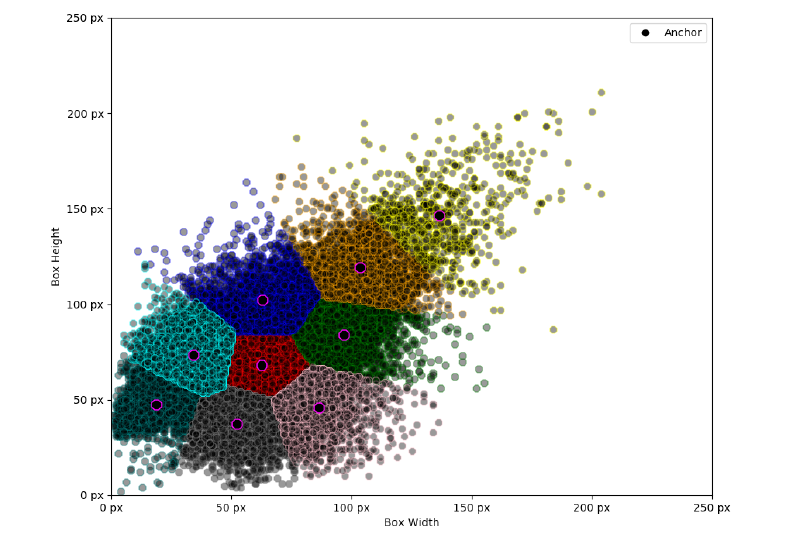
Figure 9. Each individual point denotes the mean object bounding box scale for each class type.